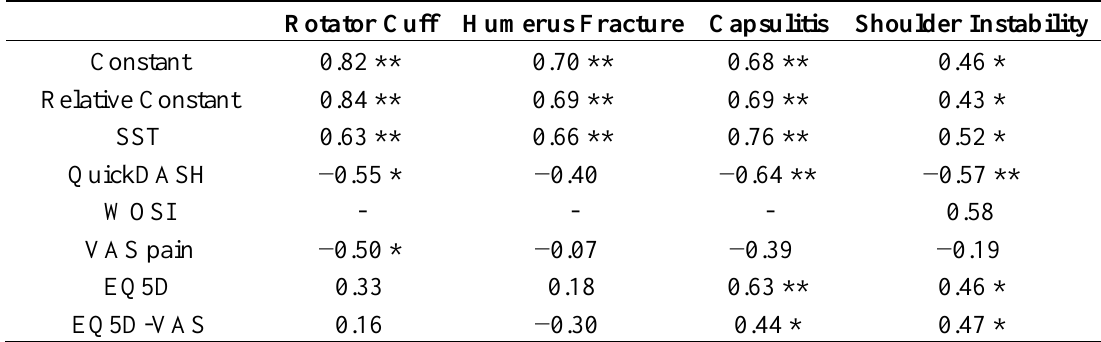
Table 5. Spearman correlation coefficients between B-B Score and clinical